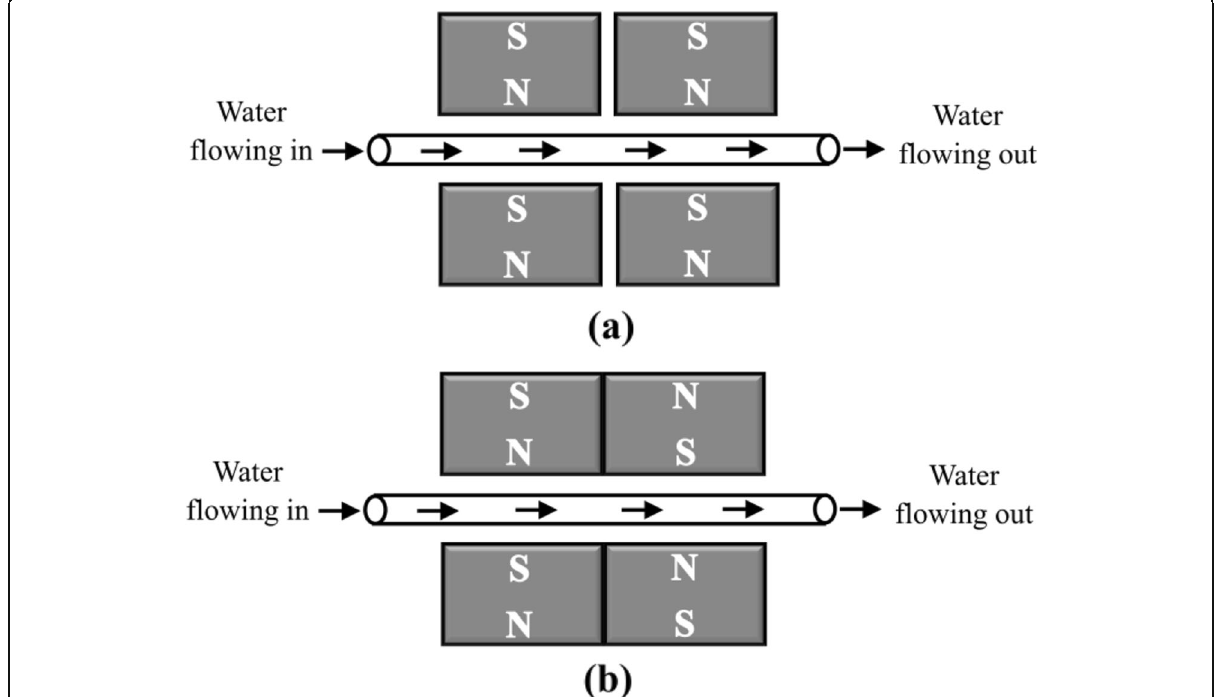
Fig. 2 The magnets arrangements used in the study: a non-reversed polarity; and b reversed